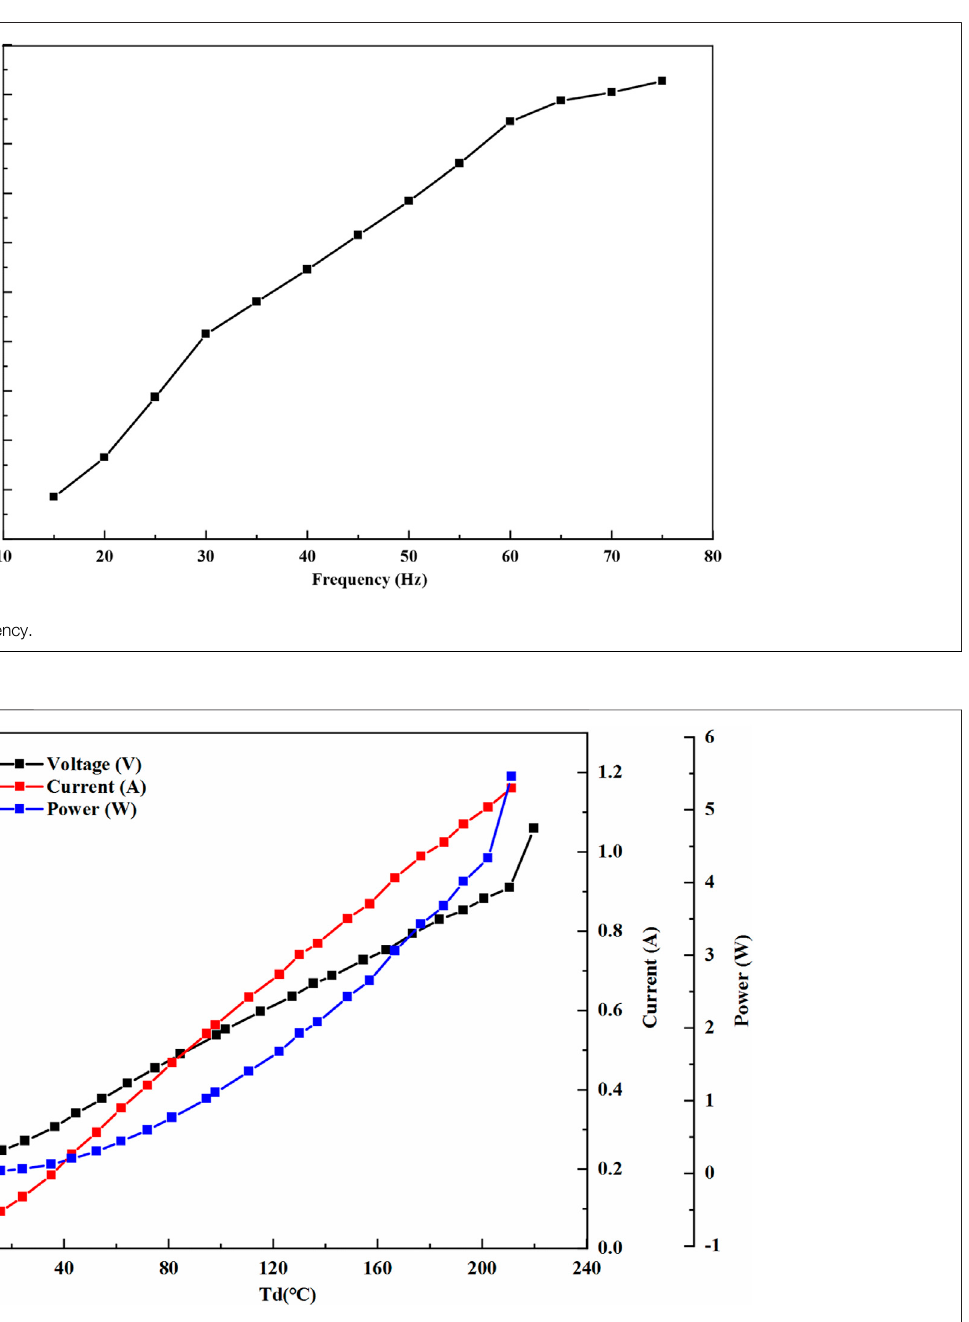
FIGURE 5 | Single TEG power generation performance with the